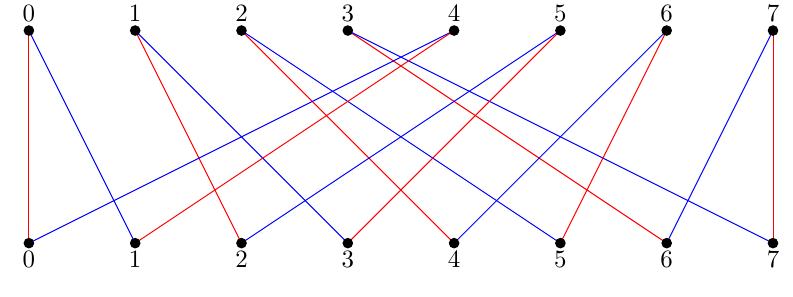
Figure 8: Coloured de Bruijn graph for s =